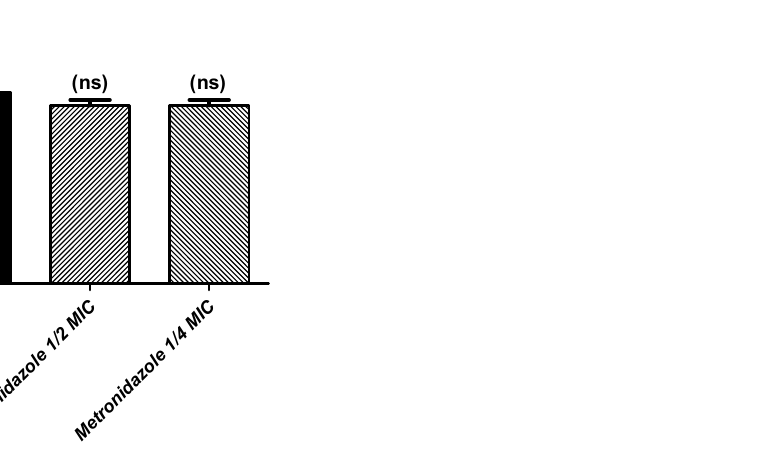
Figure 2. Effect of metronidazole in sub-MIC on P. mirabilis virulence enzymes. One-way ANOVA test was employed to compare between the metronidazole in ½ MIC or ¼ MIC treated and un- treated bacterial cultures. The data were presented as mean ± standard error of percentage change from untreated cultures; and were considered statistically significant when p values < 0.05. ( A ) Protease production: significantly, metronidazole reduced the protease production in comparison